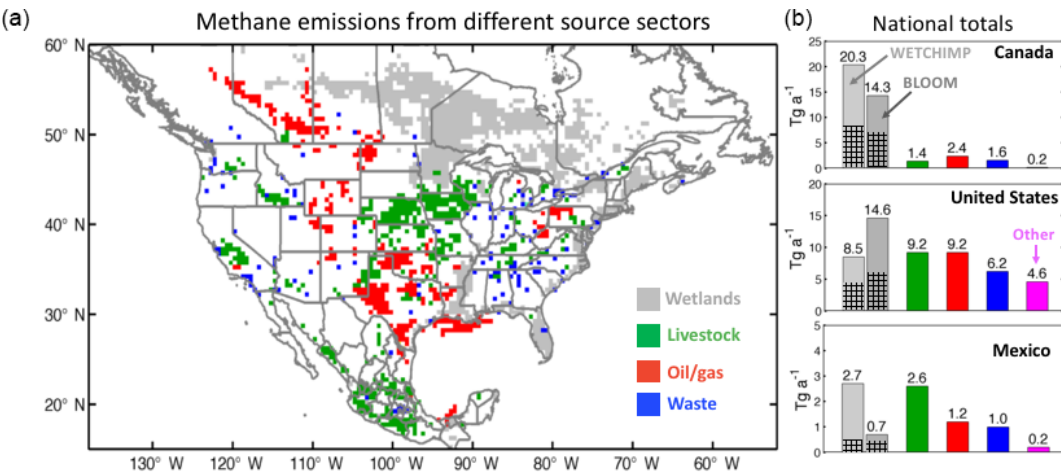
Figure 3. Methane emissions in North America and contributions from different source sectors. (a) shows 0 . 5 ◦ × 0 . 5 ◦ grid cells with high emissions dominated by a particular sector as identified by the bottom-up inventories (see text for details). High-emitting wetland areas are those identified by both the WETCHIMP mean inventory and the Bloom et al. (2017) mean inventory. Livestock includes enteric fermentation and manure management. Oil/gas includes the complete systems from production to distribution. Waste includes landfills and wastewater plants. (b) shows national emissions for 2008–2013 from the bottom-up inventories. “Other” includes smaller sources from coal, rice, combustion, petrochemical production, ferroalloy production, and biomass burning. Total emissions in the high-emitting wetland areas are indicated by gridded